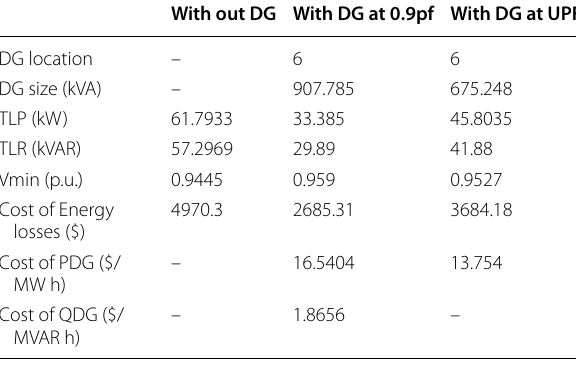
Table 4 Results for 15 bus system With out DG With DG at 0.9pf With DG at UPF